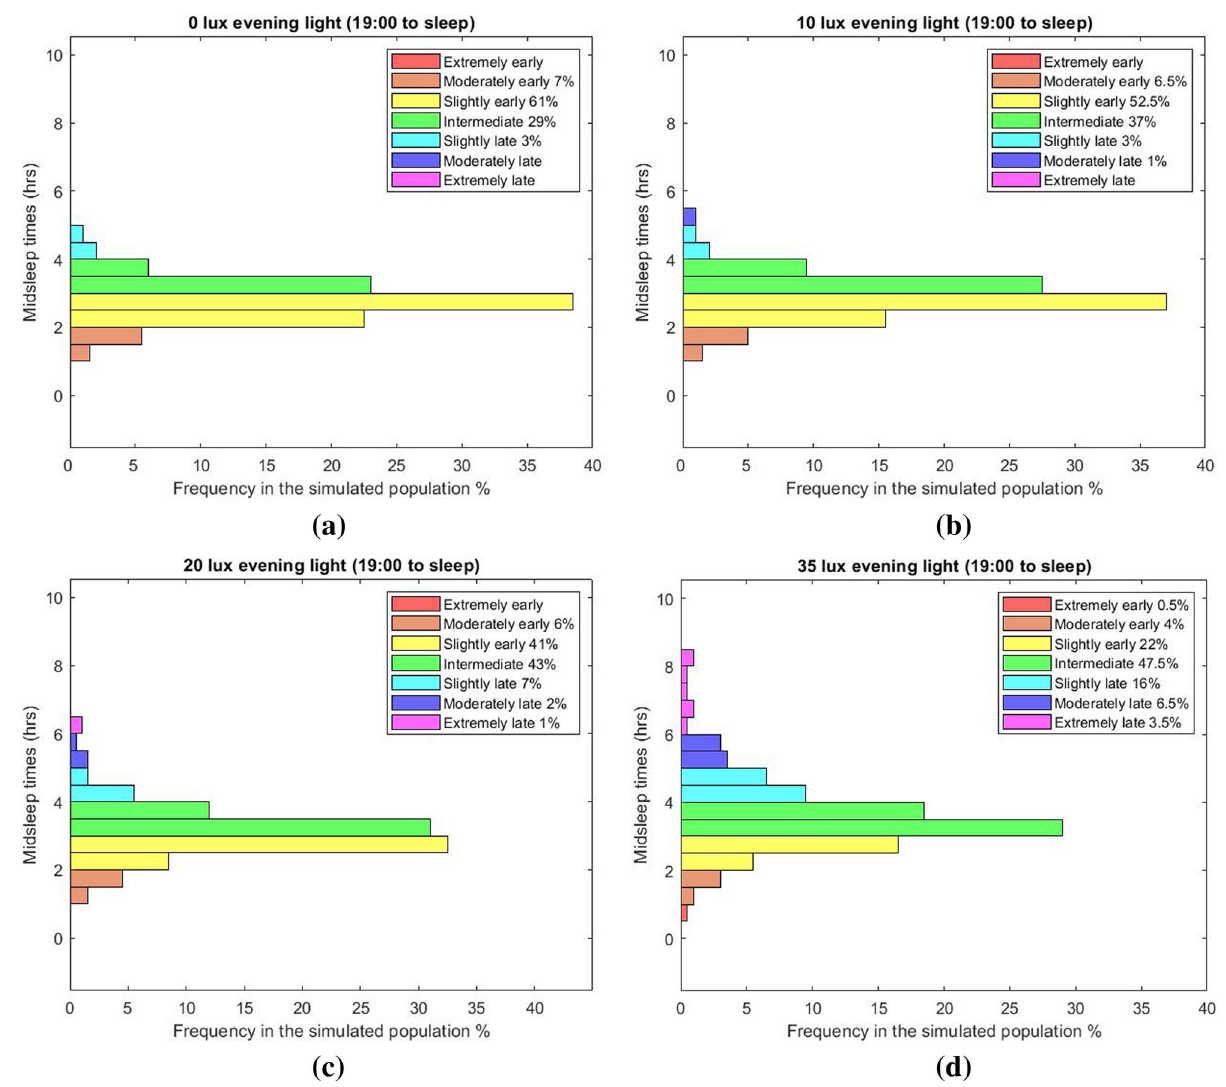
Figure 6. Model-predicted chronotype distribution under a constant daytime (wake-19:00) illuminance (L 1 ) of 200 lx (at the eye) and various evening (19:00-sleep) illuminances (L 2 ), all at the eye position: ( a ) 0 lx, ( b ) 10 lx, ( c ) 20 lx, and ( d ) 35 lx. The distributions are based on hourly bins. The population is classified into seven chronotypes indicated in the legends according to their midsleep